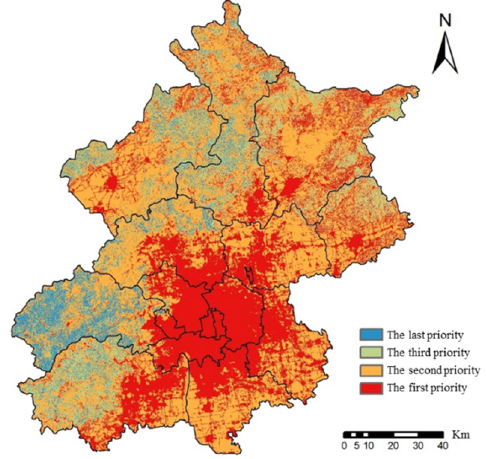
Figure 4. Pixel-scale ECC improvement priority distribution.